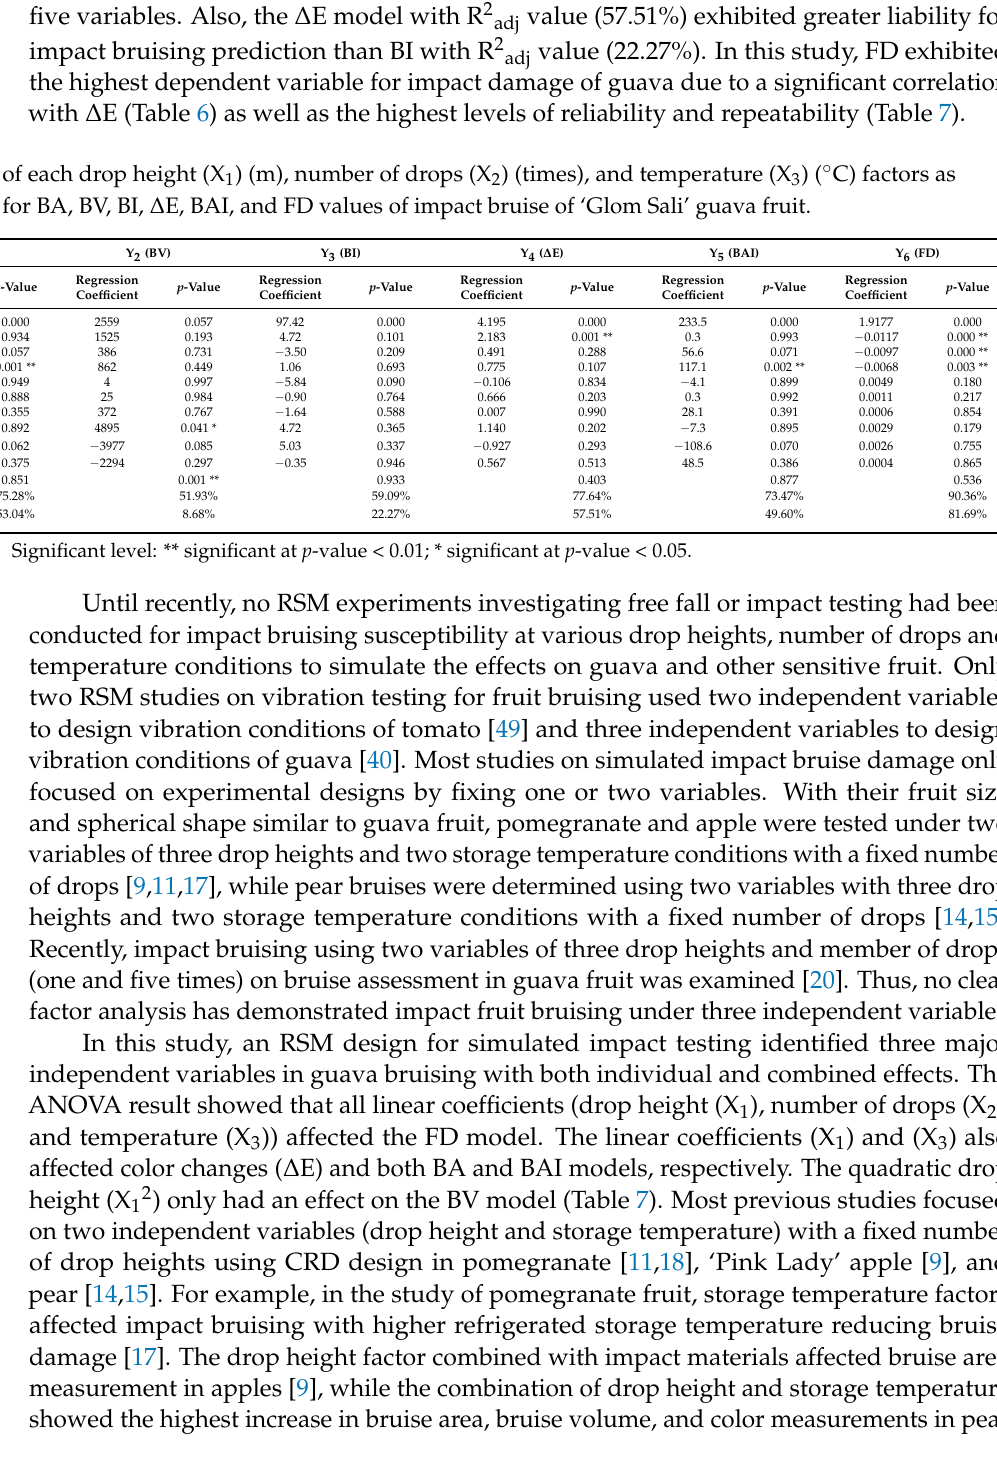
Table 7. ANOVA results of each drop height (X 1 ) (m), number of drops (X 2 ) (times), and temperature (X 3 ) ( ◦ C) factors as response surface models for BA, BV, BI, ∆ E, BAI, and FD values of impact bruise of ‘Glom Sali’ guava fruit. CoefficientTerms